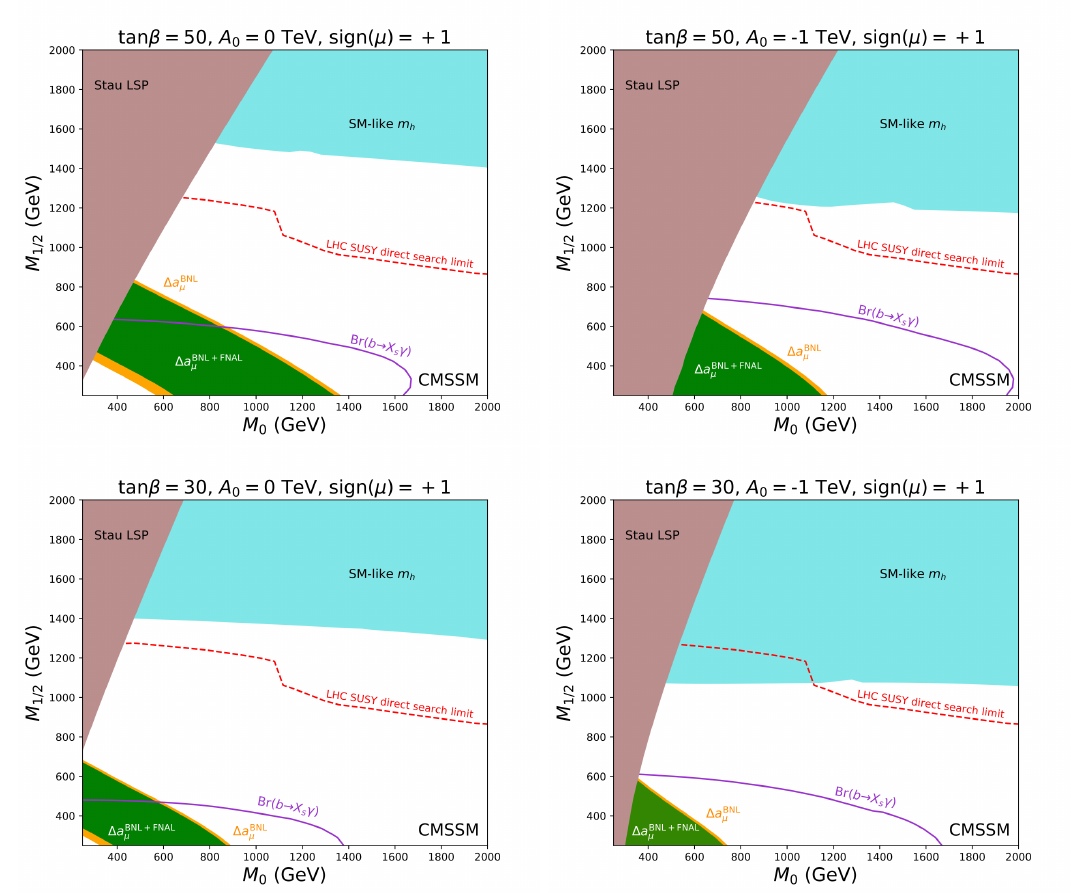
Figure 1 . Tensions between the ∆ a FNAL+BNL / BNL µ explanation and the relevant experimental limits in CMSSM, showing on the plane of ( M ) for sign ( µ ) = +1 , A = 0 TeV (left), 1 TeV (right) 0 , M 1 / 2 0 and tan β = 50 (upper), 30 (lower). The panels are taken from our previous work [70]. In the panels, the green regions satisfy the combined FNAL+BNL results, while the orange regions plus the green regions are consistent with the previous BNL measurements. The areas below the red dash and purple curves are excluded by LHC direct search bounds for sparticles and Br( b → sγ ) bound, respectively. The blue shaded regions are consistent with the present Higgs mass measurement, with 2 GeVtheoretical uncertainty. In the brown shaded areas, LSP is the charged ˜ τ , which is 1 excluded. All the limits are shown at 2 σ